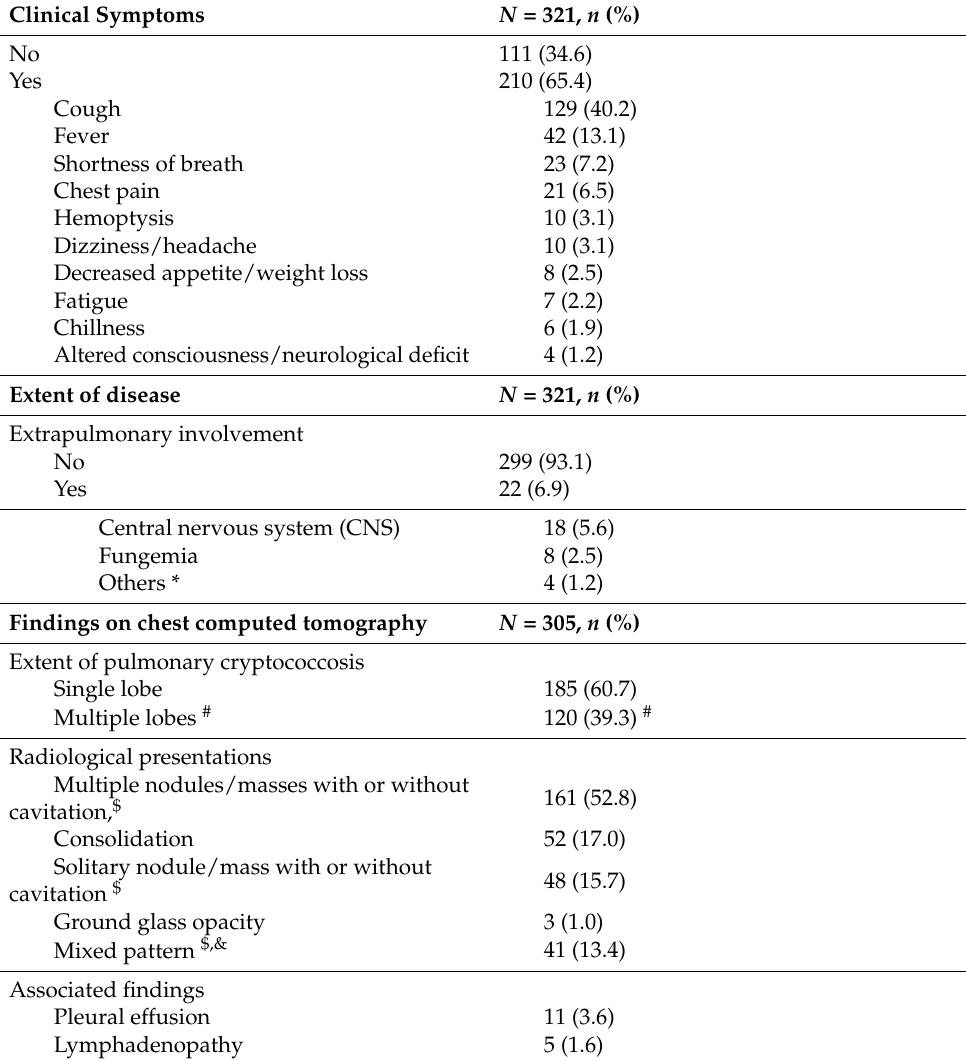
Table 2. Clinical and radiological presentations of pulmonary